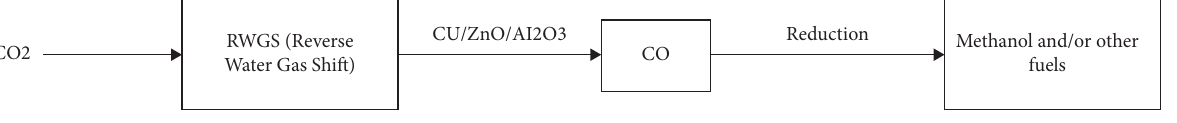
Figure 17: Flowchart of RWGS to produce methanol from CO